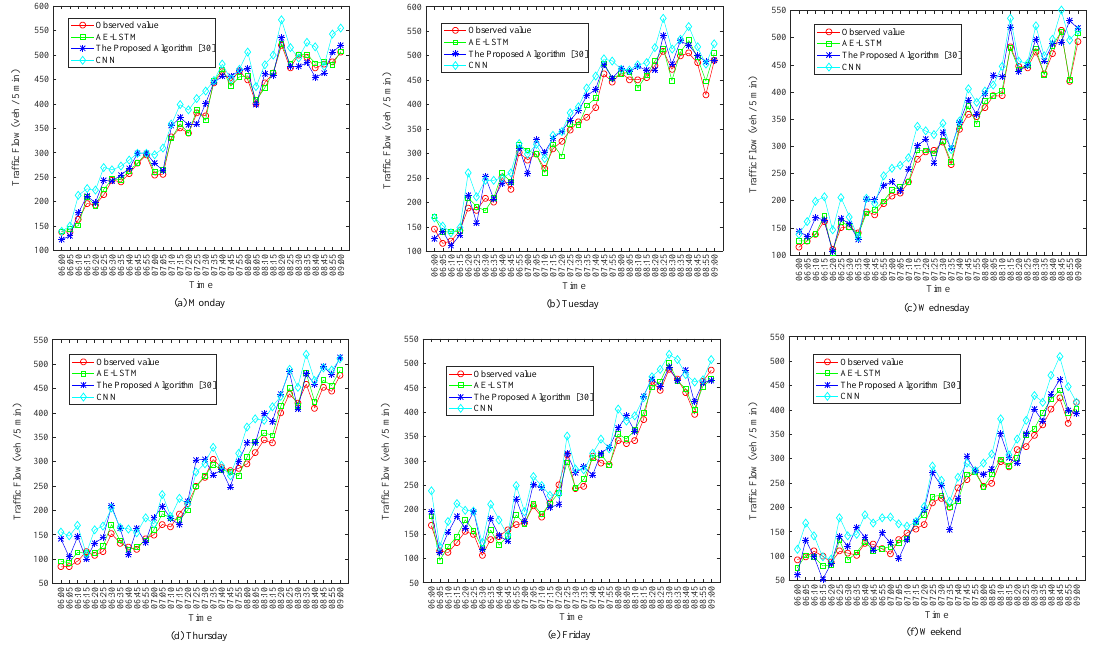
Figure 9. Observed and predicted values of traffic flow from 6:00 to